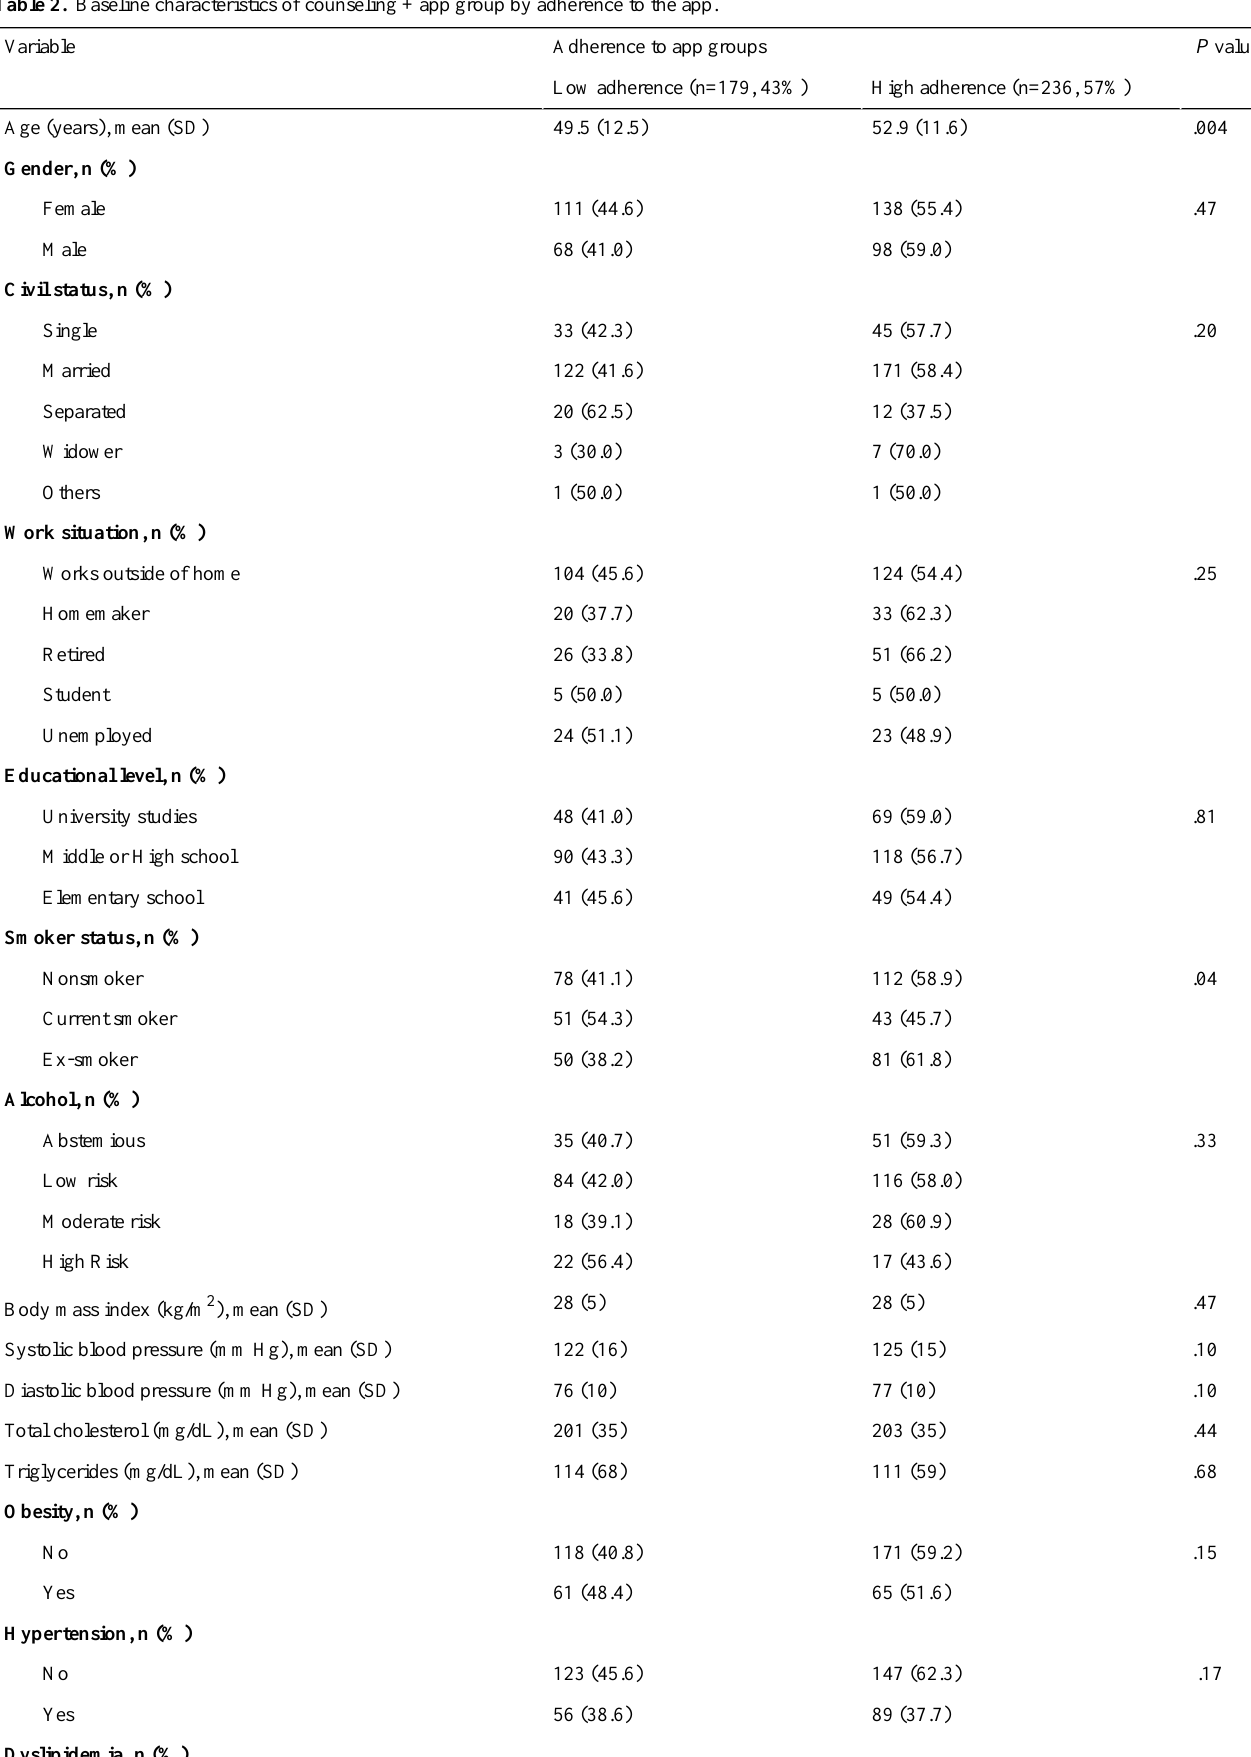
Table 2. Baseline characteristics of counseling + app group by adherence to the app.